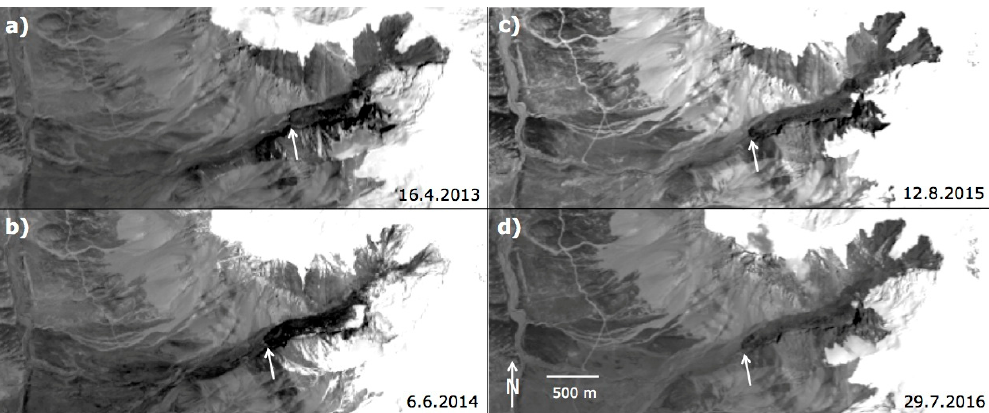
Figure 9. Time series of the 2013–2016 surge as seen with the Landsat 8 OLI panchromatic band. The white arrow marks the position of the terminus. Image acquisition dates are: ( a ) 16 April 2013, ( b ) 6 June 2014, ( c ) 12 August 2015, and ( d ) 29 July 2016. Image source: earthexplorer.usgs.gov. The Sentinel-2 image from 4 August 2017 shows the deposit in nadir-view (Figure 10d) and was used to digitize its extent. It is smaller (area 1.25 km 2 ) than the one from 2007 and the avalanche has this time seemingly not overtopped the moraine walls at the end of the short valley. Hence, all material was diverted to the south-west and the deposit covers a larger region here than in 2007; very similar to 2004 (Figure 11). However, it reached not that far down, i.e. did likely not cross the main river. The inset in Figure 8 shows a subset of the fresh deposits on top of the former ones.